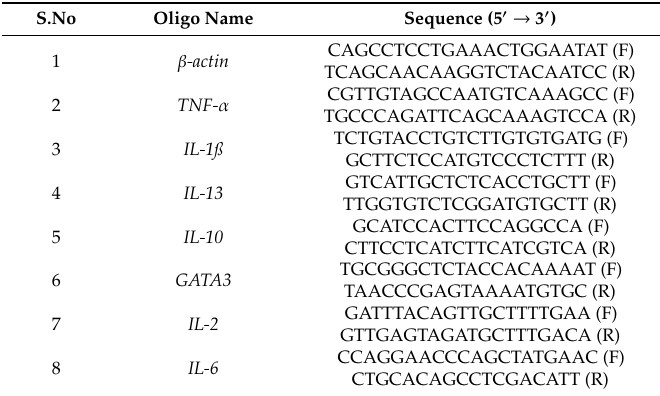
Table 2. Sequence of the primers used in qRT-PCR